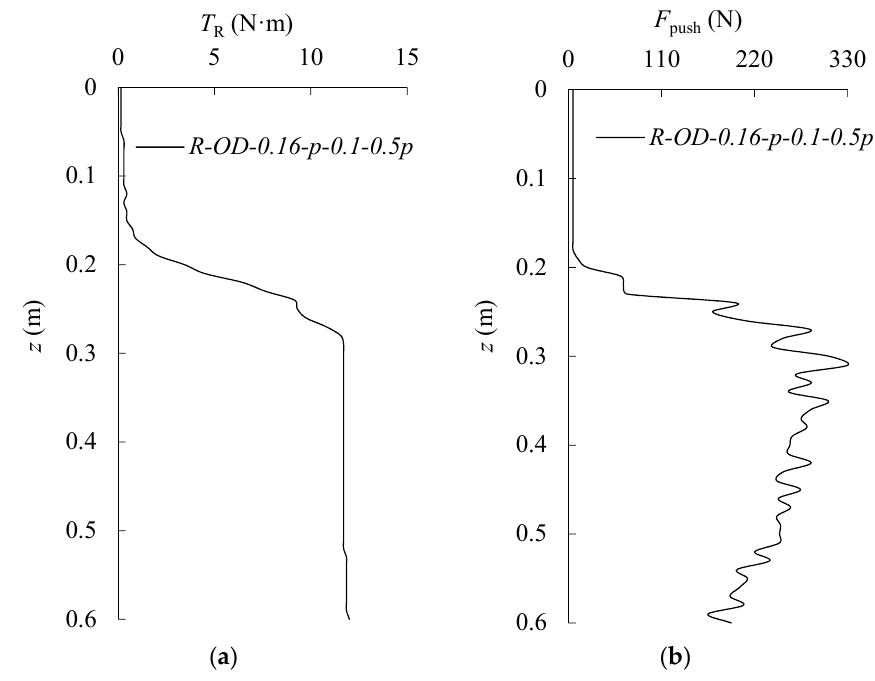
Figure 11. The test results of TN-6. ( a ) Recycling torque. ( b ) Vertical force on